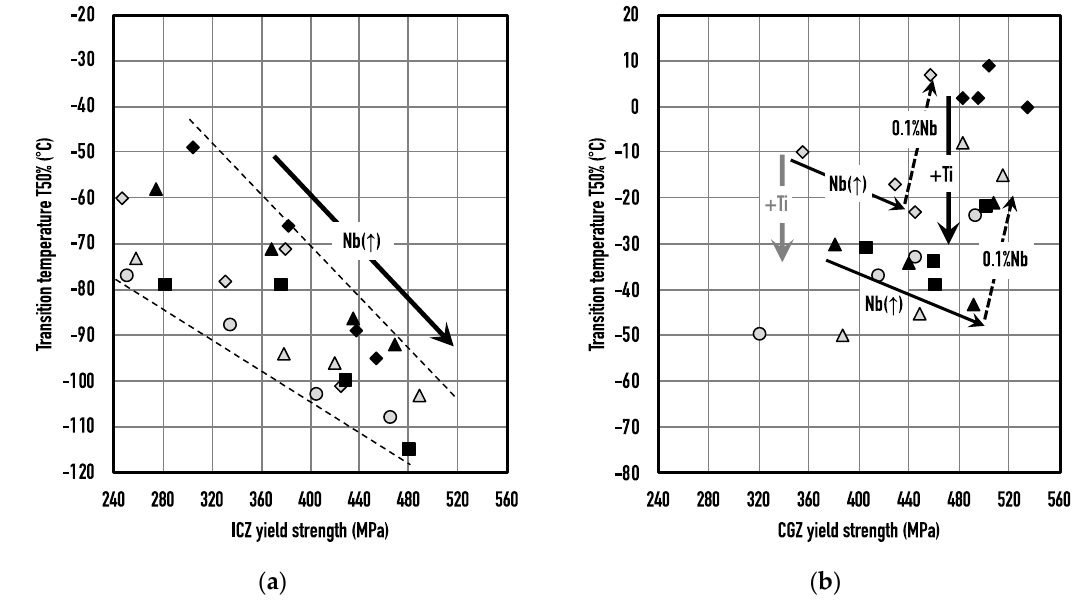
Figure 7. Ductile-to-brittle transition temperature (DBTT T50%) determined by Charpy testing: ( a ) Simulated intercritcal HAZ (ICZ) with a peak temperature of 900 °C; ( b ) simulated coarse-grained ( a ) Simulated intercritcal HAZ (ICZ) with a peak temperature of 900 ◦ C; ( b ) simulated coarse-grained HAZ (CGZ) with a peak temperature of 1300 °C. HAZ (CGZ) with a peak temperature of 1300 ◦